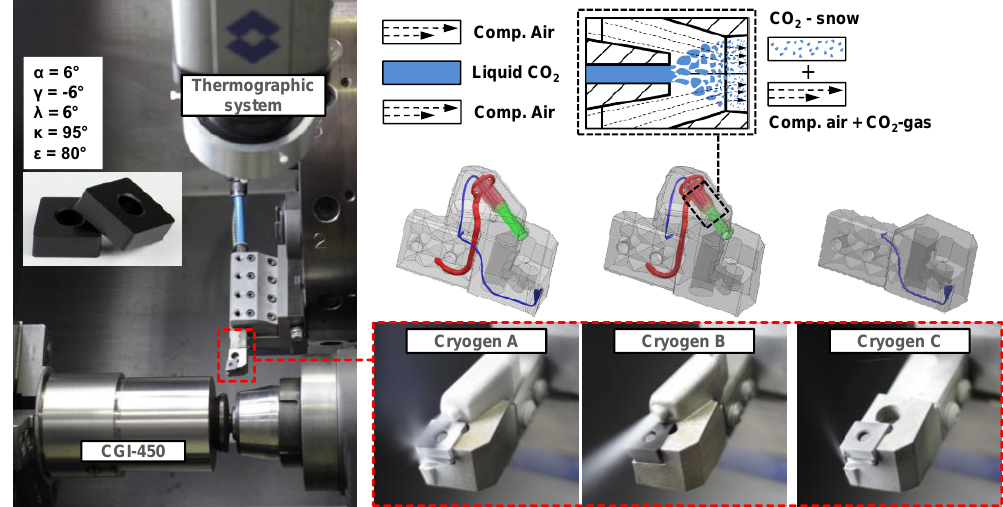
Figure 2. Experimental setup used to analyze the influence of the supply strategy with CO 2 -snow on the thermomechanical tool load.